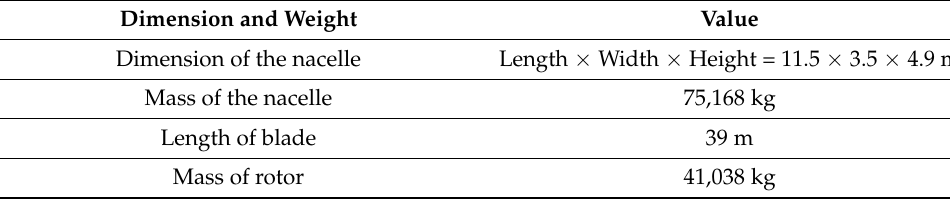
Table 1. Description of the dimension and weight of UWT80d-2.0.